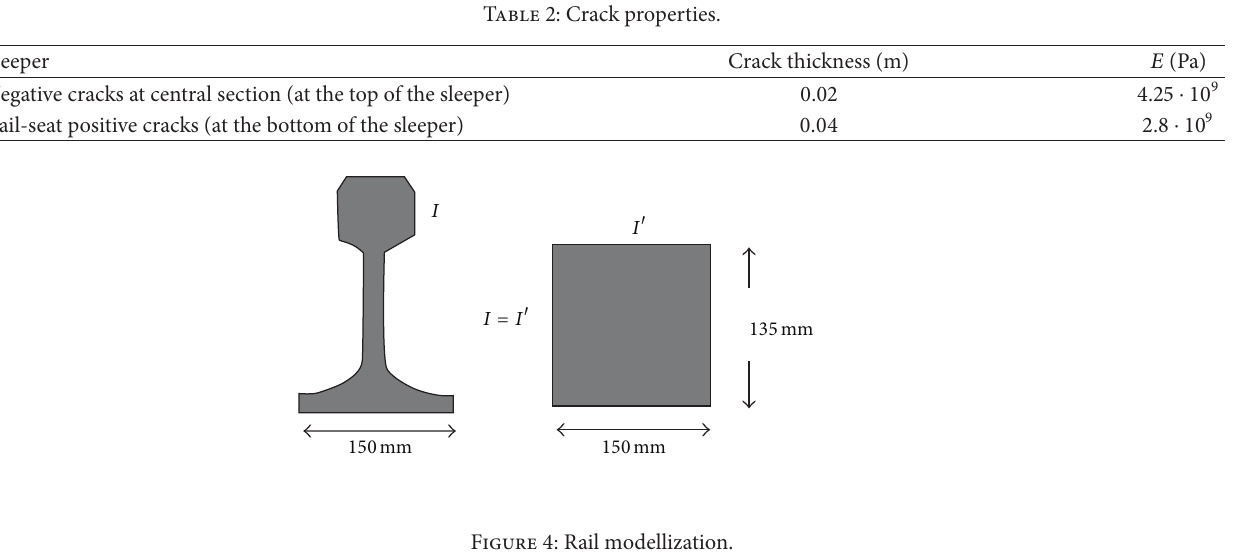
Figure 4: Rail modellization.